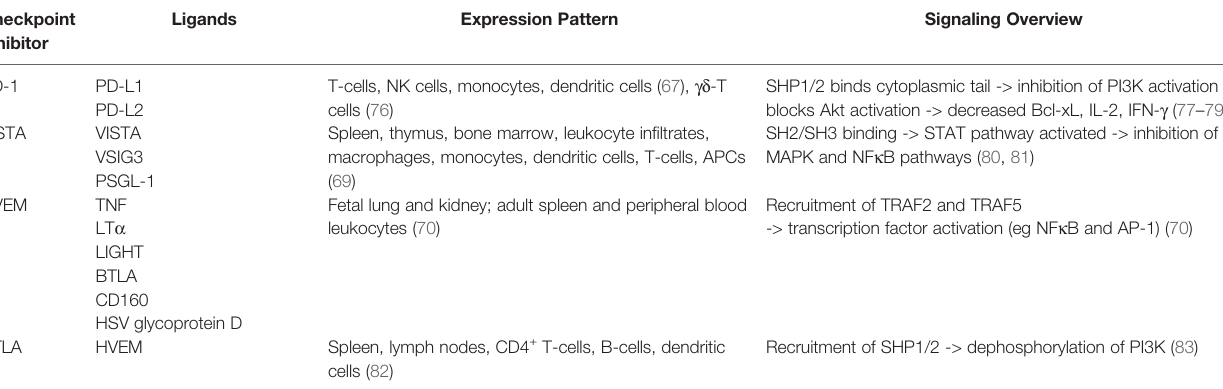
TABLE 1 | Brief summary of some selected checkpoint inhibitor ligands, expression, and signaling with relevance to the present discussion of neonatal sepsis. Checkpoint Ligands Expression Pattern Signaling Inhibitor